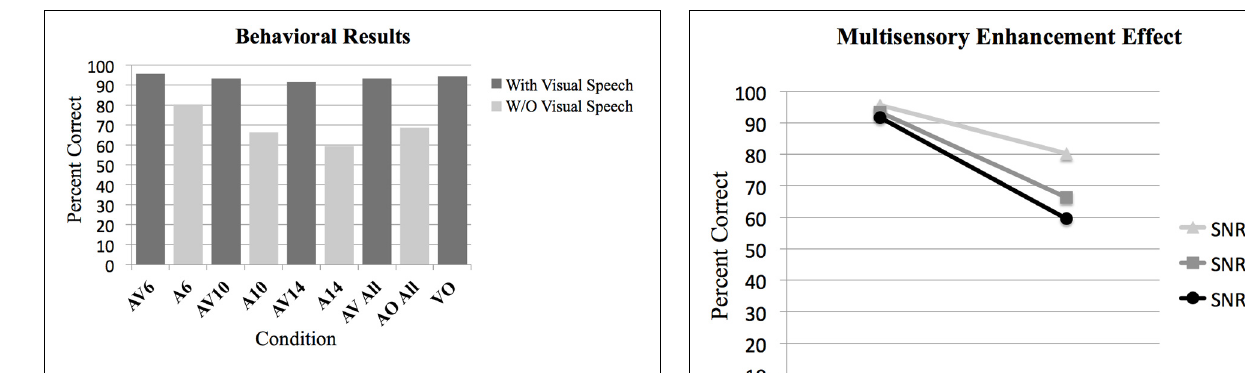
FIGURE 1 | Behavioral results as measured by percent correct on the two-alternative forced choice vowel identification task for the following conditions. Audio Visual AV6 ( − 6dB SNR), Audio A6 ( − 6dB SNR), AV10, A10, AV14, A14, All AV conditions combined, all A conditions combined, Video with noise VN, and Video only VO without noise. All contrasts were significantly greater than chance performance of 50% ( p < 0 . 01). Table 2 | T -Tests for conditions evaluating better than chance performance.